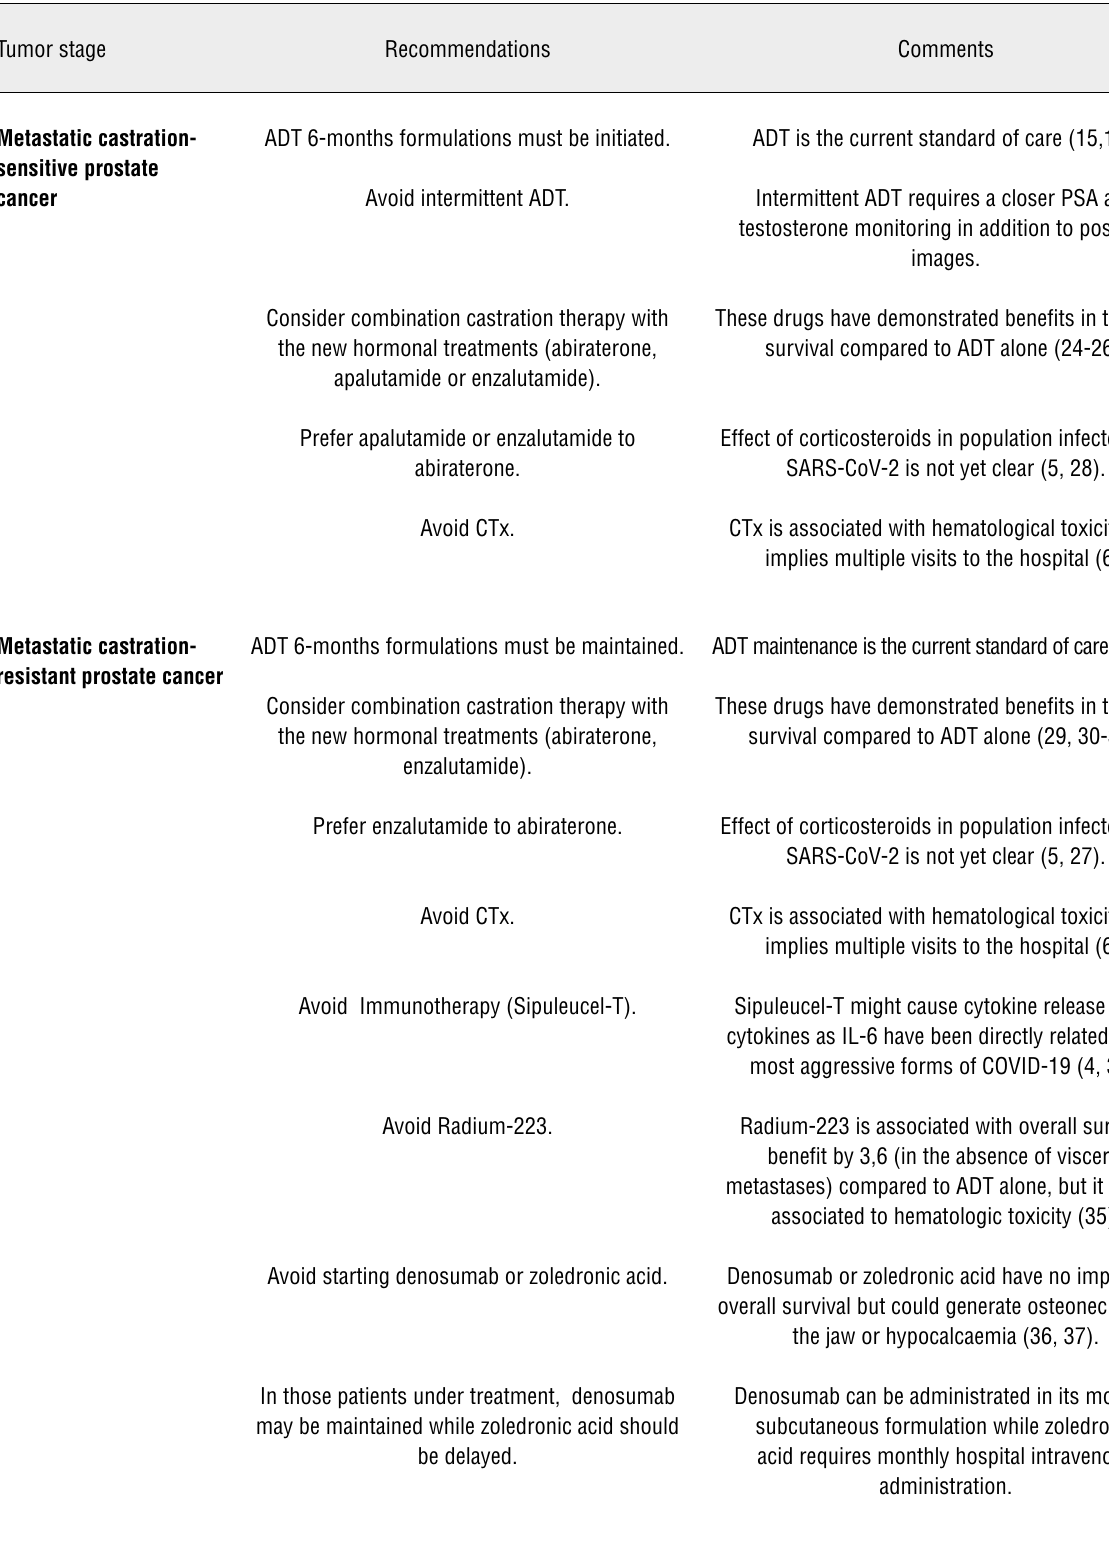
Table 4 - Management of metastatic PCa during the COVID-19